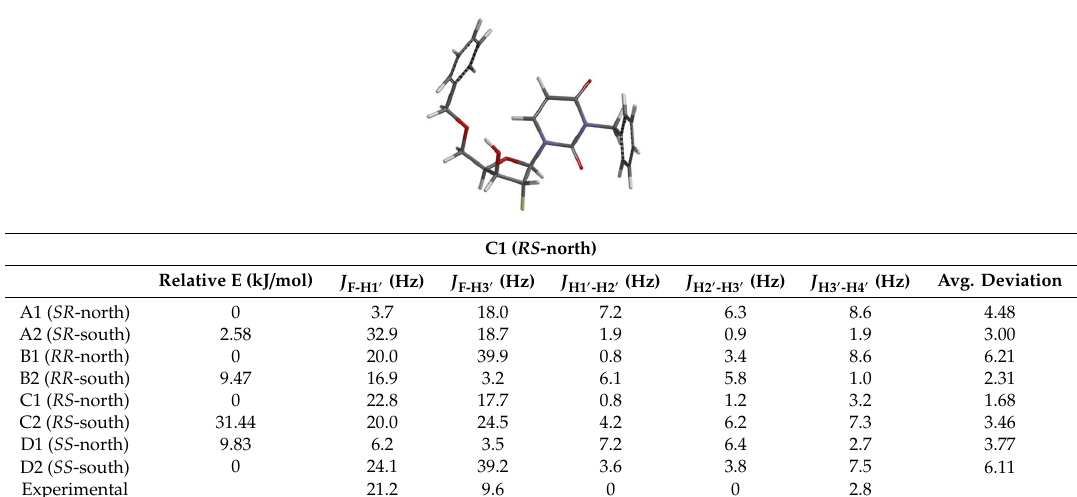
Table 1. Spin-spin coupling constants (calculated and experimental values) for conformers A1–D2 of compound 12 . Coupling constants are shown in Hz. Experimental values were recorded in CDCl 3.